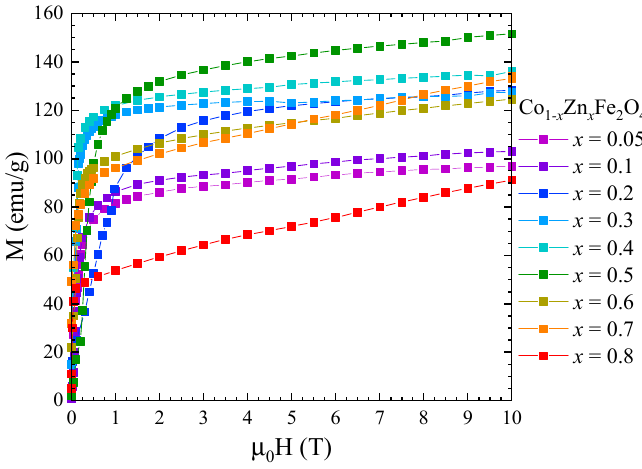
Figure 7. Magnetization isotherms of Co 1 − x Zn x Fe 2 O 4 nanoparticles recorded at 4 K. One can see that the saturation magnetization increases at the beginning when Zn concentration increases with a maximum at x = 0.5, followed by a strong decrease in the higher Zn content—Figure 8. Previous studies reported a maximum value of the saturation magnetization for x = 0.2 [27] and x = 0.4 [26,28]. The fact that in our case